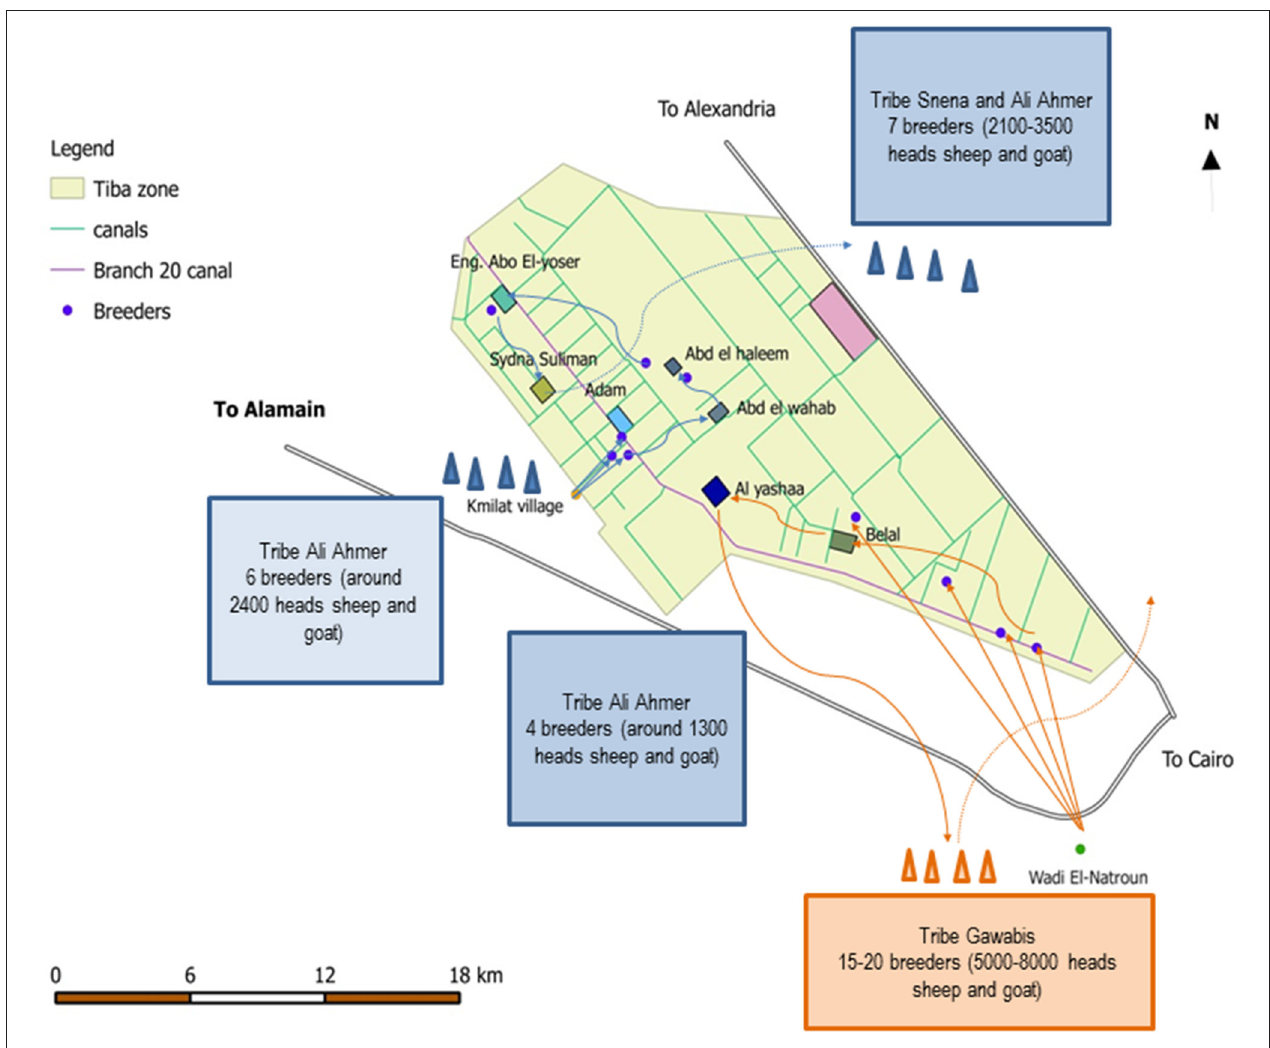
FIGURE 4 | Herd grazing circuits for the three Bedouins tribes in the Tiba zone (based on interviews).